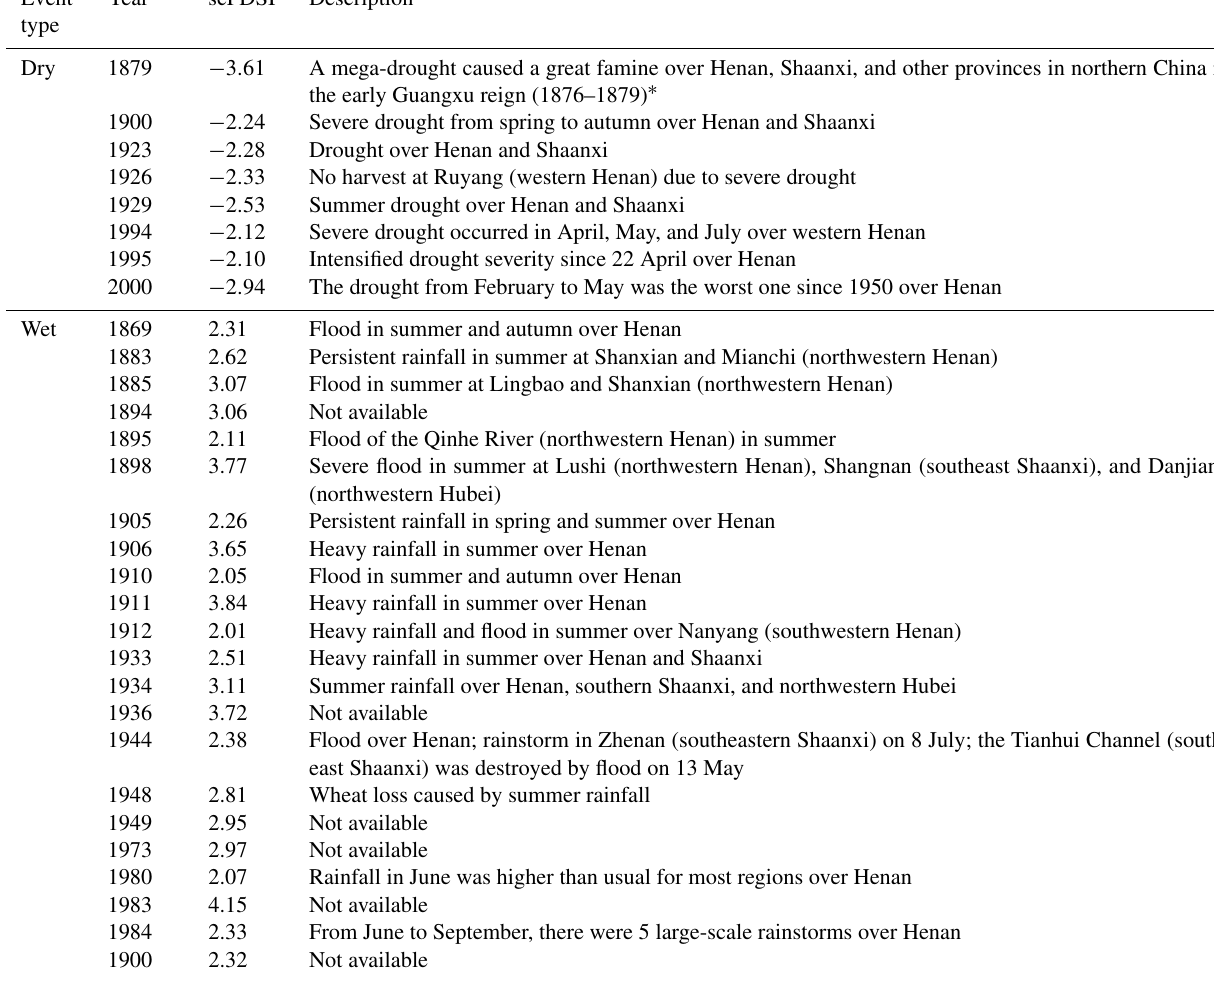
Table 4. Moderately to severely dry (scPDSI ≤− 2) and wet (scPDSI ≥ 2) events derived from the MJJ scPDSI reconstruction and corre- sponding descriptions from historical